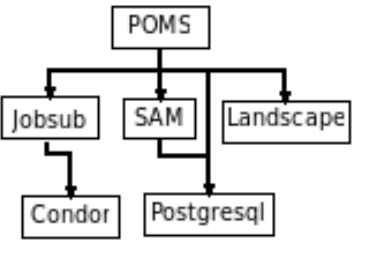
Figure 1. POMS Related